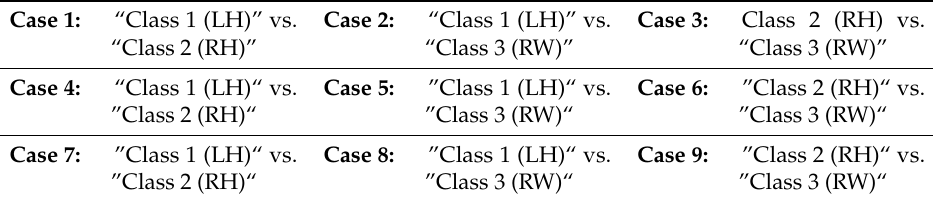
Table 4. Different cases consider for SDI experimental work by employing dataset V.